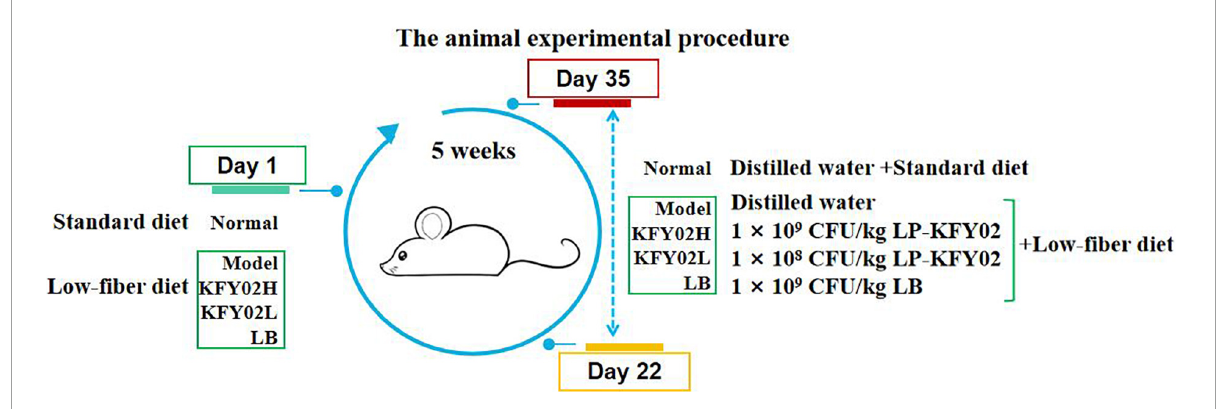
FIGURE1 Implementation process of animal experiment in this study.